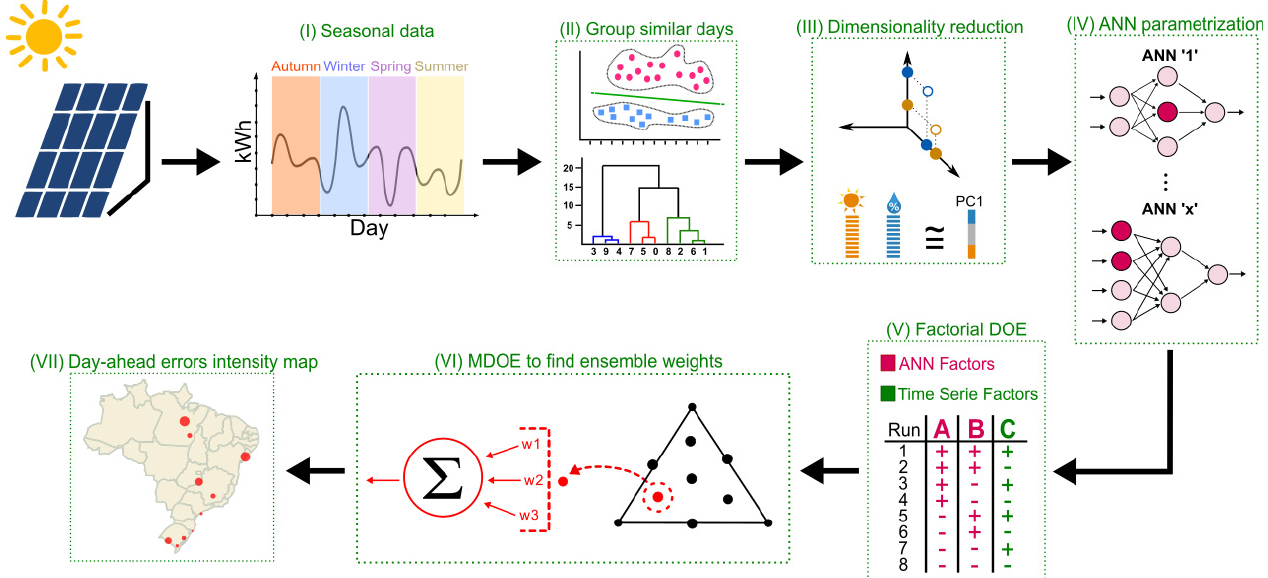
Figure 1. Proposed strategy for photovoltaic (PV) generation forecast using cluster analysis, principal component analysis (PCA), artificial neural network (ANN), design of experiments (DOE) and Mixture DOE (MDE). Source: own authors.